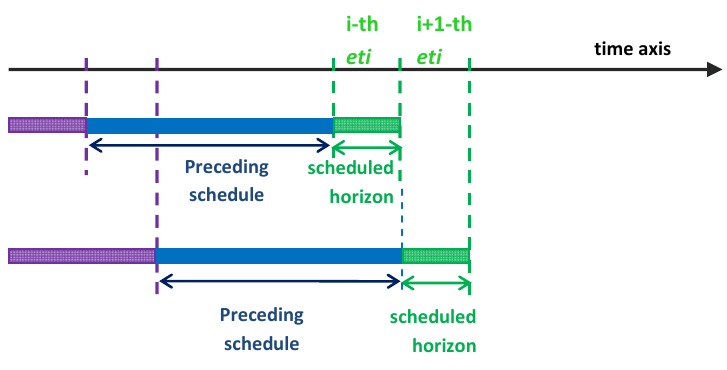
Figure 3. The proposed forecast-less rolling horizon